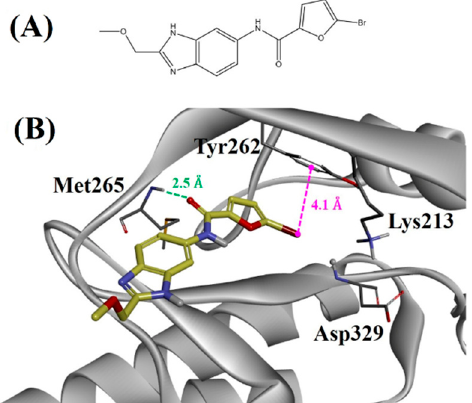
Figure 5. ( A ) Two-dimensional structure of compound 2 . ( B ) Binding mode of compound 2 against IRAK4. The green and magenta lines represent hydrogen bond and hydrophobic interactions, The green and magenta lines represent hydrogen bond and hydrophobic respectively. interactions,